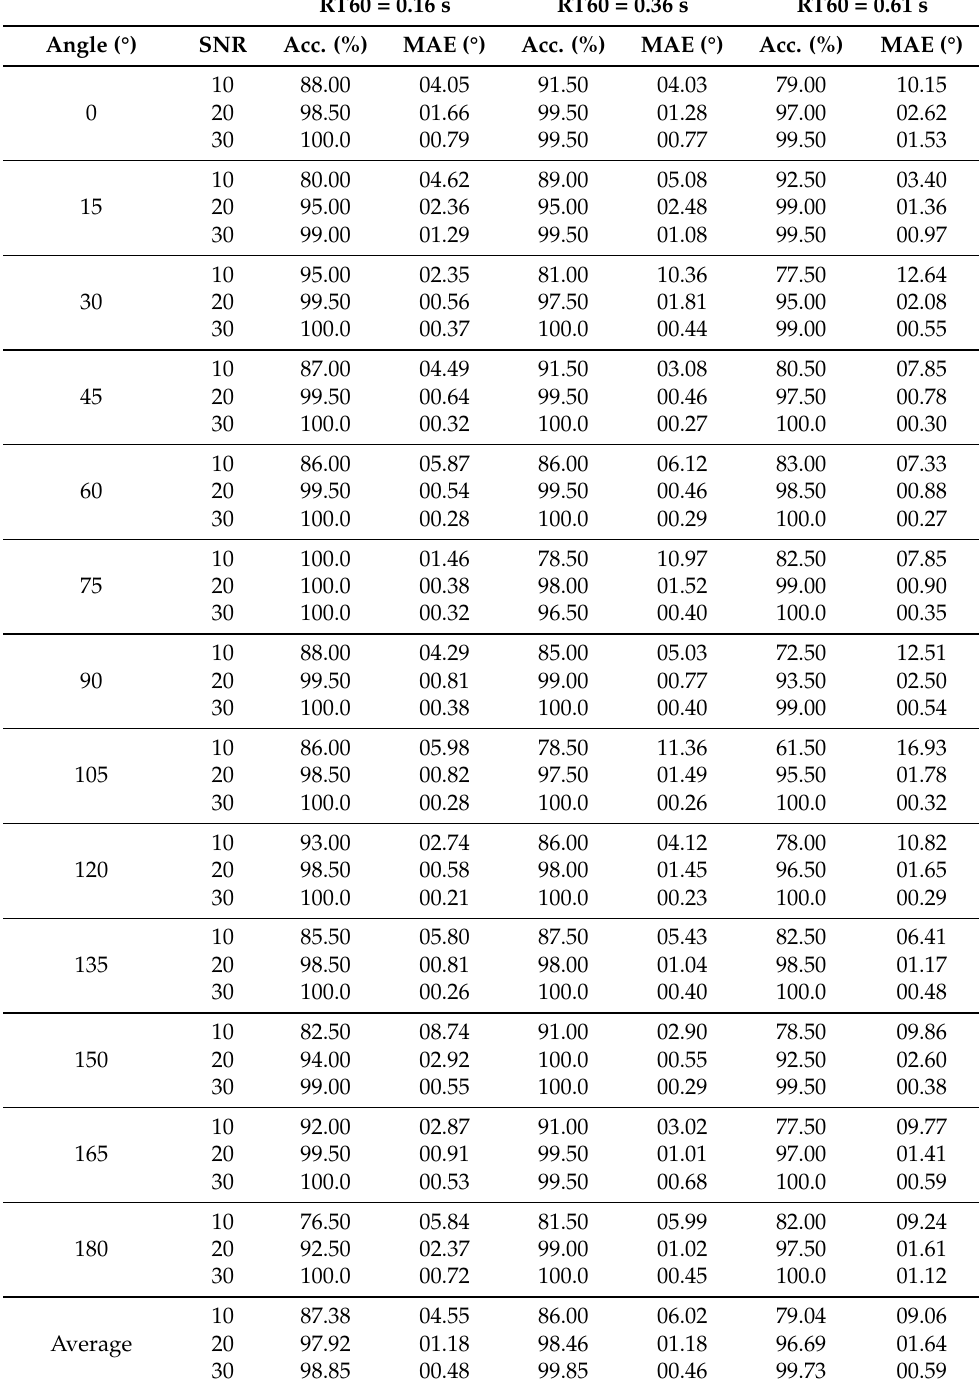
Table 10. Performance of angle estimation by CNN-R in a real acoustic environment at SNRs of 10, 20, and 30 dB, and RT60 = 0.16 s, 0.36 s, and 0.61